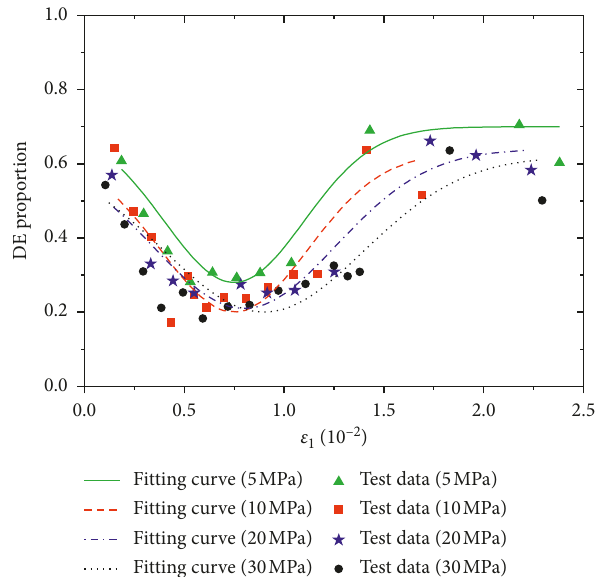
Figure 11: Experimental and fitting curves of DE proportion.